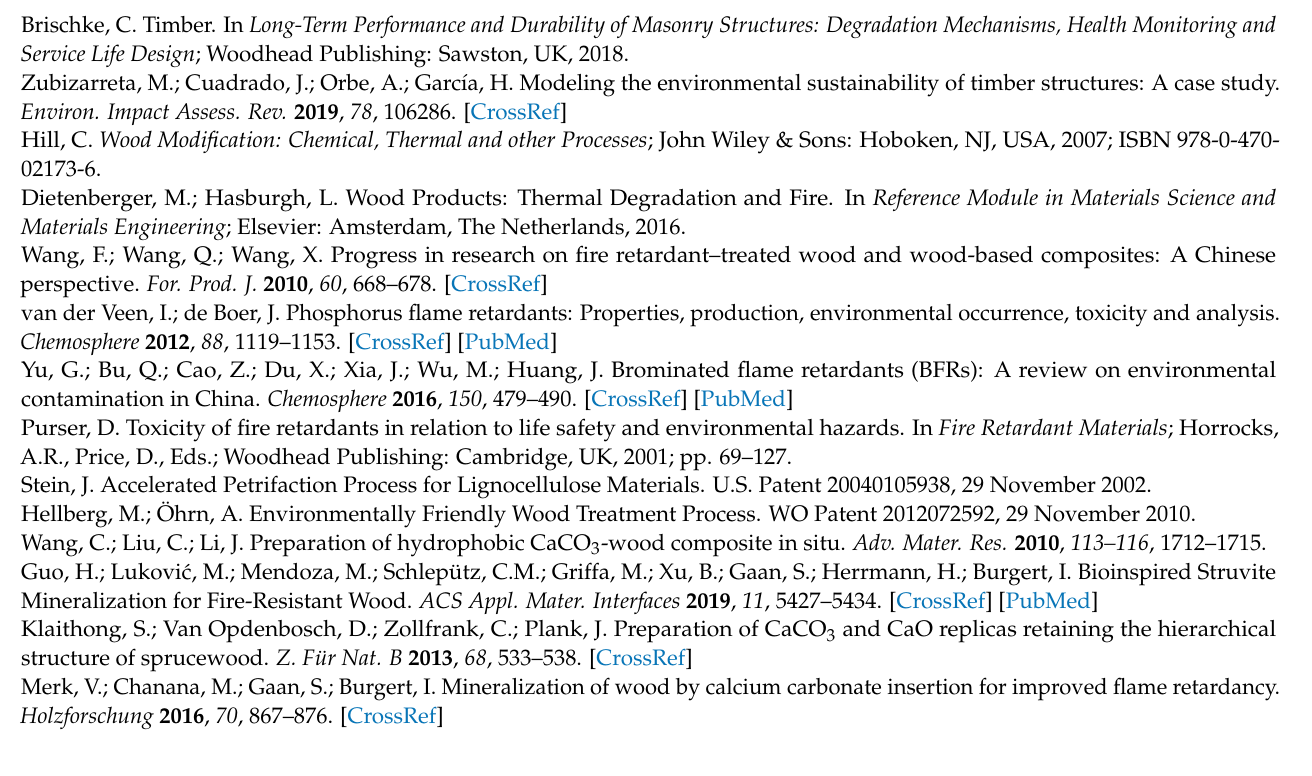
mineralized samples; Figure S2: Analysis of variance of weight losses after the fire-resistance test; Figure S3: Analysis of variance of the carbonization index after the fire-resistance